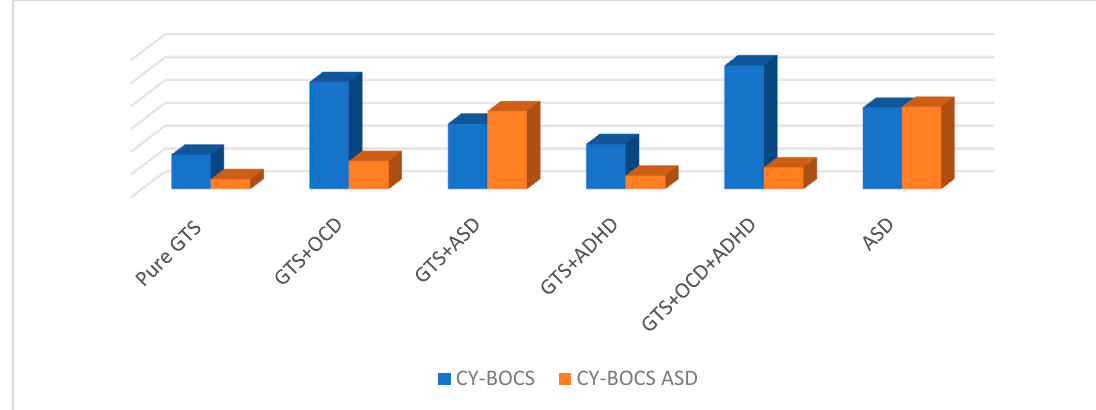
Figure 2. Comparison between CY-BOCS and CY-BOCS ASD scores between clinical groups. GTS: Gilles de la Tourette Syndrome; ASD: Autism Spectrum Disorder; OCD: Obsessive–Compulsive Disorder; ADHD:AttentionDeficitHyperactivityDisorder; CY-BOCS:ChildrenYaleBrownObsessive–Compulsive